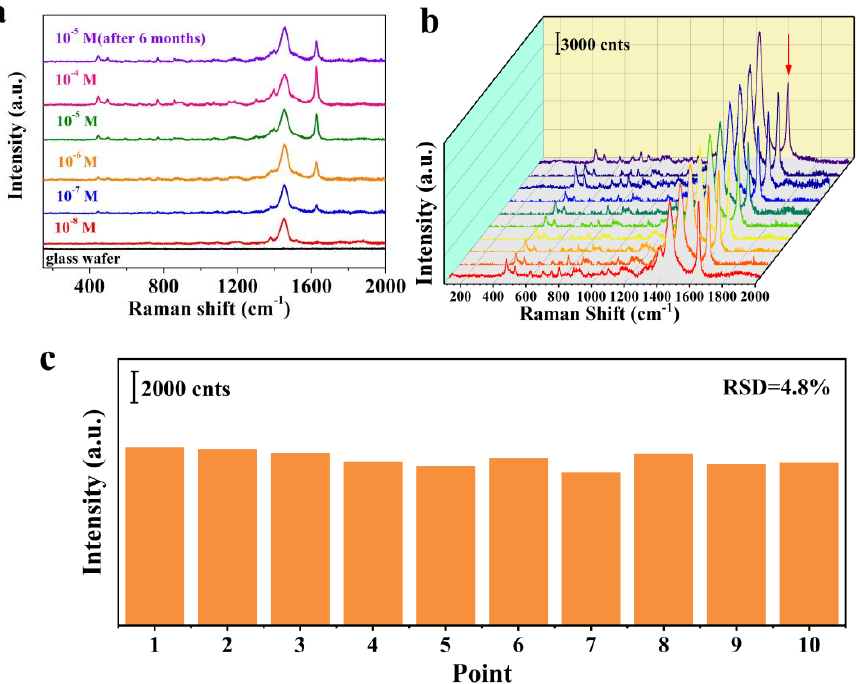
Figure 10. ( a ) SERS spectra of different concentrations of MB on the composite substrate, ( b ) MB (10 − 5 M) SERS spectra of 10 random points on the composite substrate. ( c ) Raman intensity (at 1621 cm − 1 ) of MB (10 − 5 M) acquired from 18 different spots in ( b ).